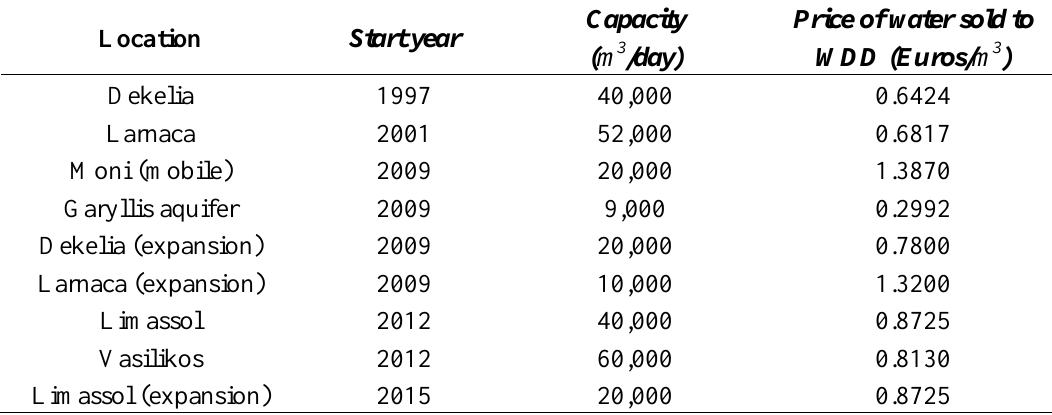
Table 3. Desalination plants in operation or scheduled to operate in Cyprus (except in the area of